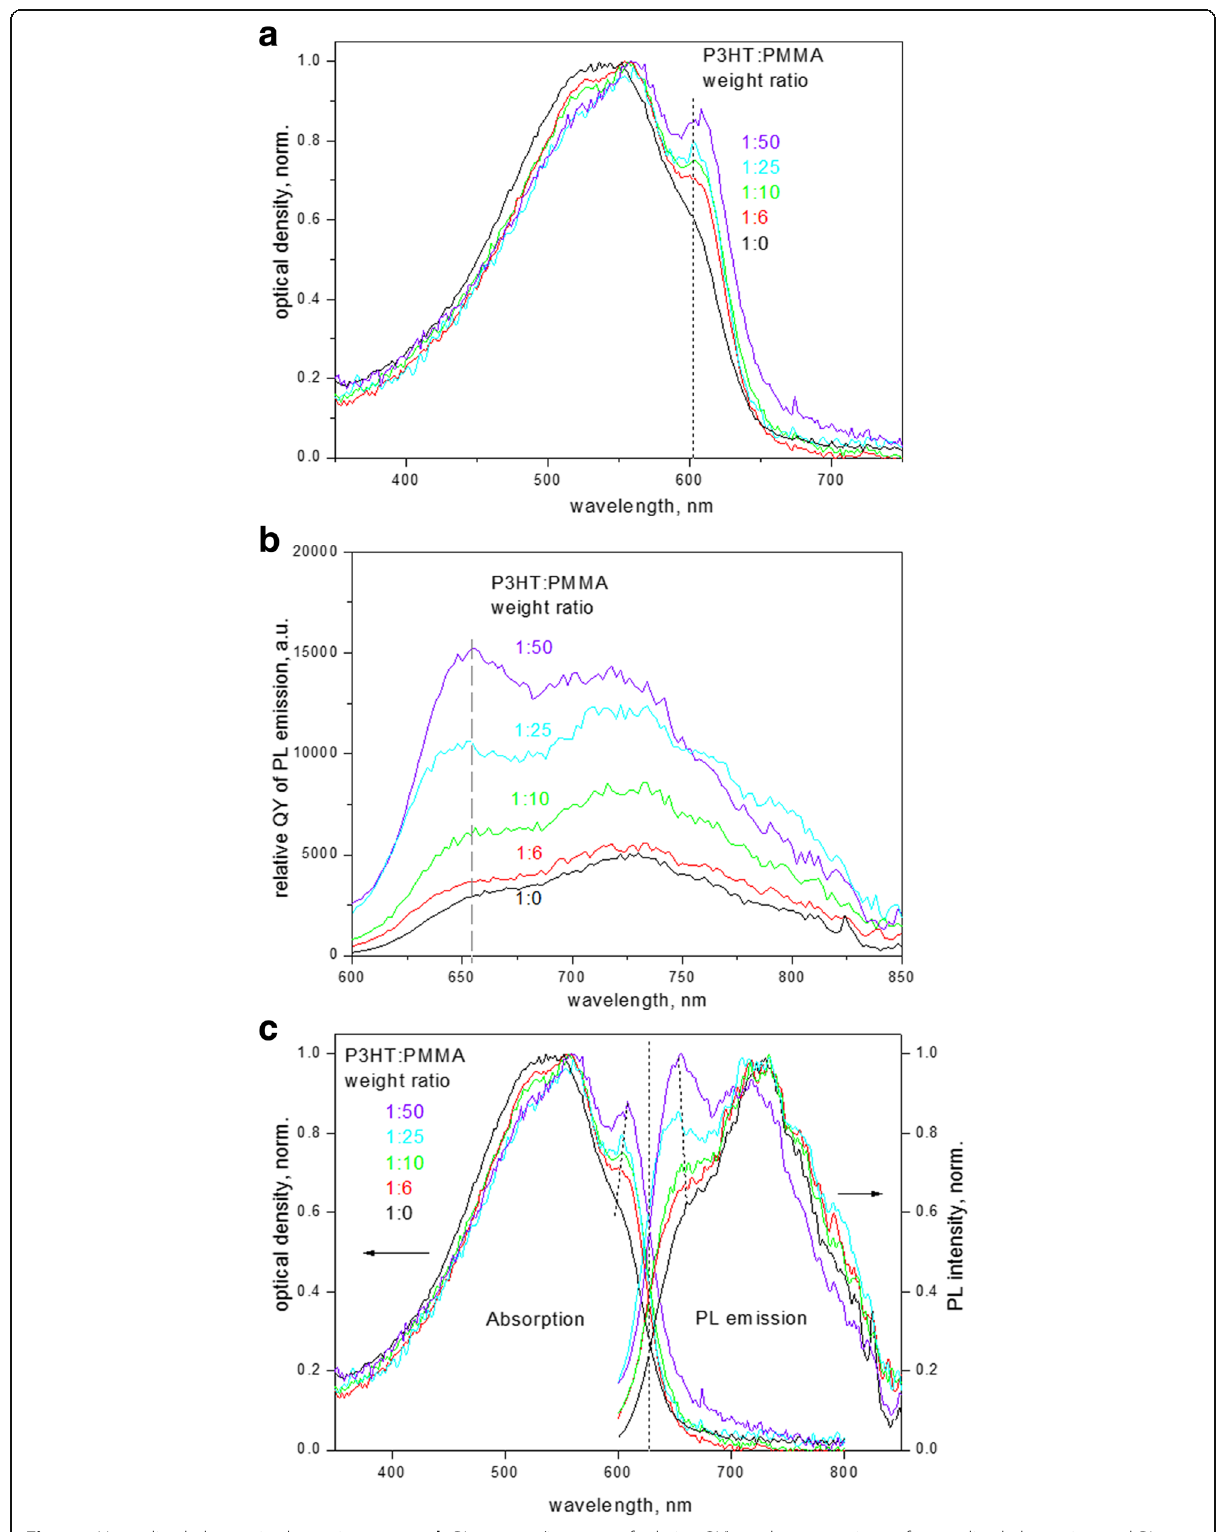
Fig. 1 a Normalized electronic absorption spectra, b PL spectra (in terms of relative QY) and c comparison of normalized absorption and PL spectra of P3HT-PMMA composite films with different P3HT:PMMA weight